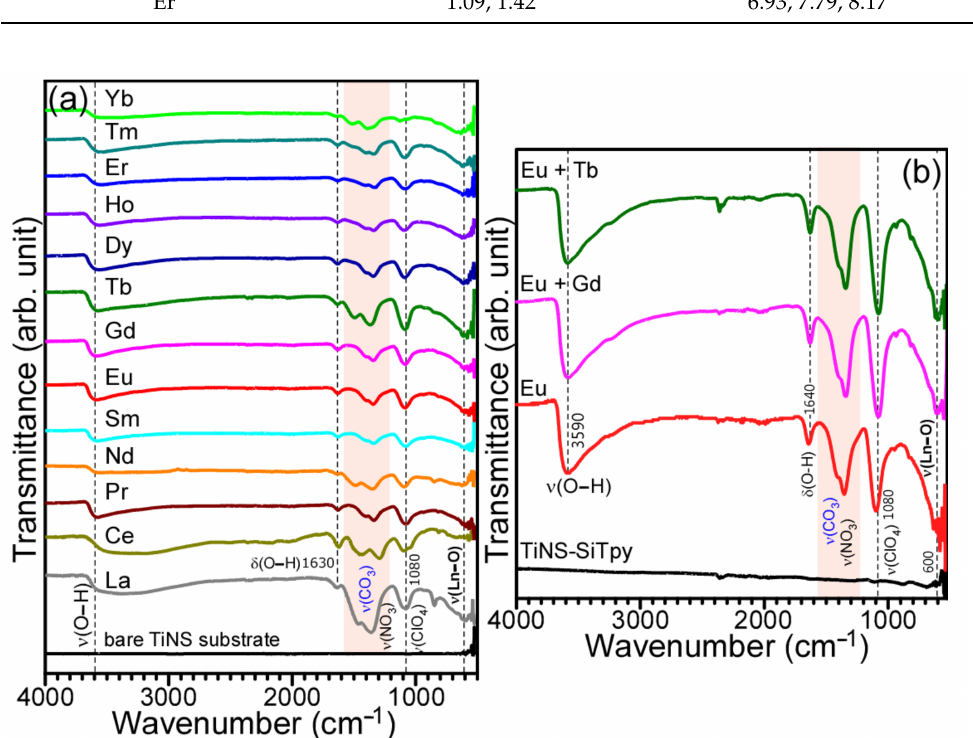
Figure 4. Transmittance FT-IR (Fourier-transform infrared) spectra of electrodeposited Ln ( a ) and electrodeposited Eu ( b , red line), Eu + Gd ( b , pink line), and Eu + Tb ( b , green line) on TiNS- SiTpy